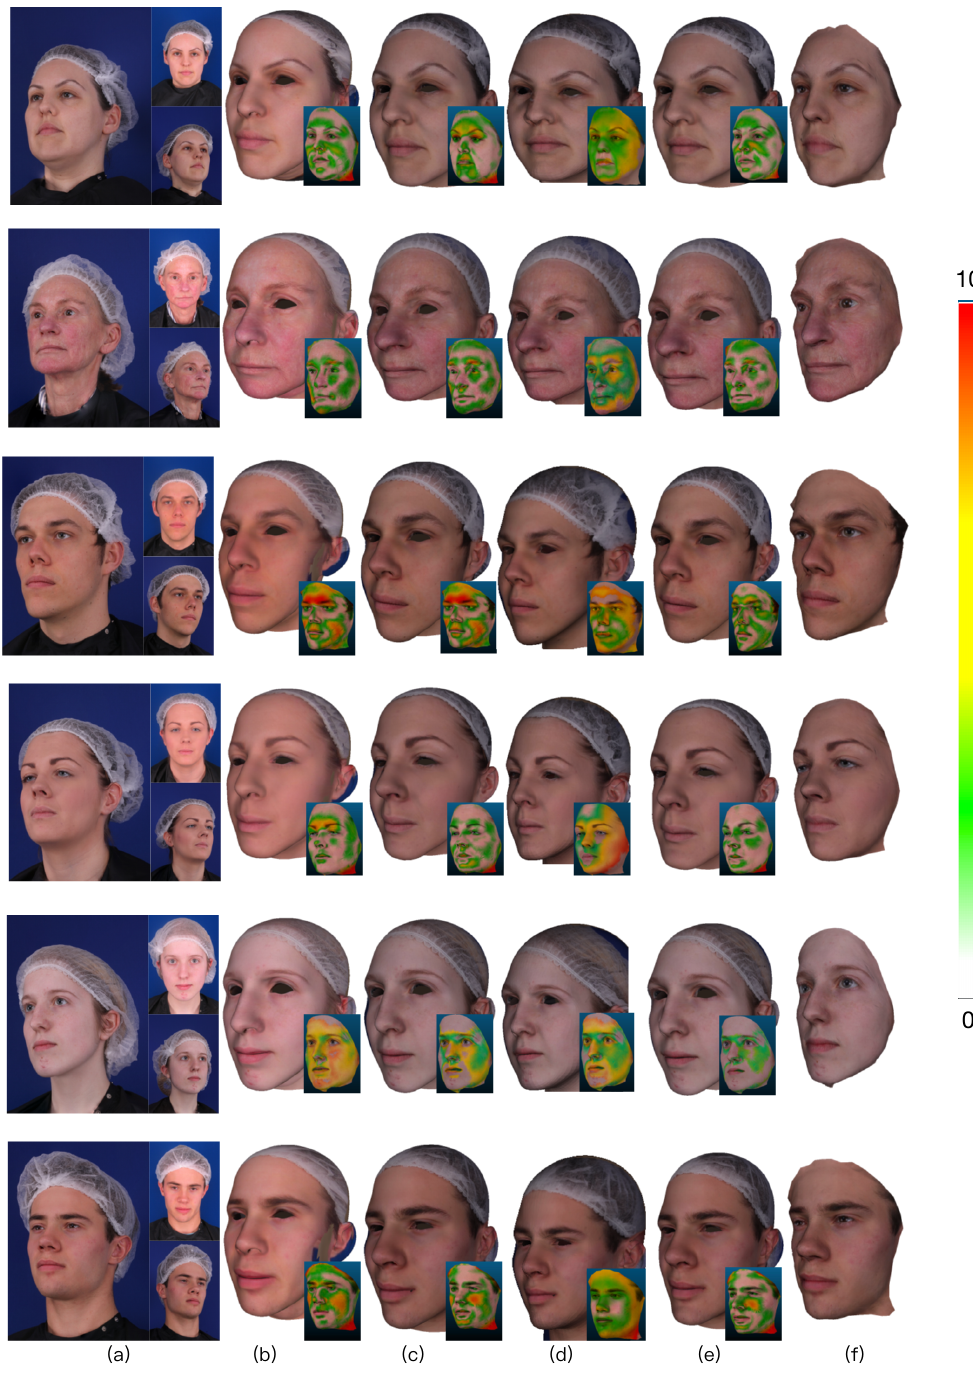
Figure 8. The comparison results. The range of vertex error is from 0mm to 10 mm as the color strip varies in the color bar. ( a ) Three viewpoint images. ( b ) Result using method [7] and its comparison result. ( c ) Result using the proposed method without texture constraint and its comparison result. ( d ) Result using the proposed method without feature prior constraint and its comparison result. ( e ) Result using the proposed method with all constraints and its comparison results. ( f ) The